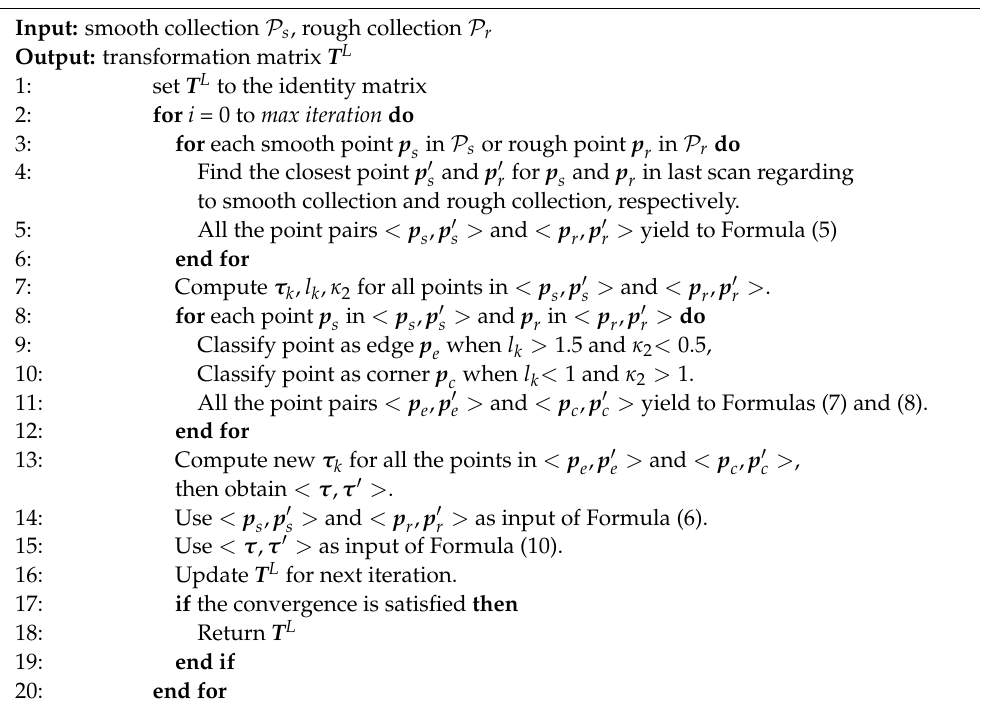
Algorithm 1: Motion